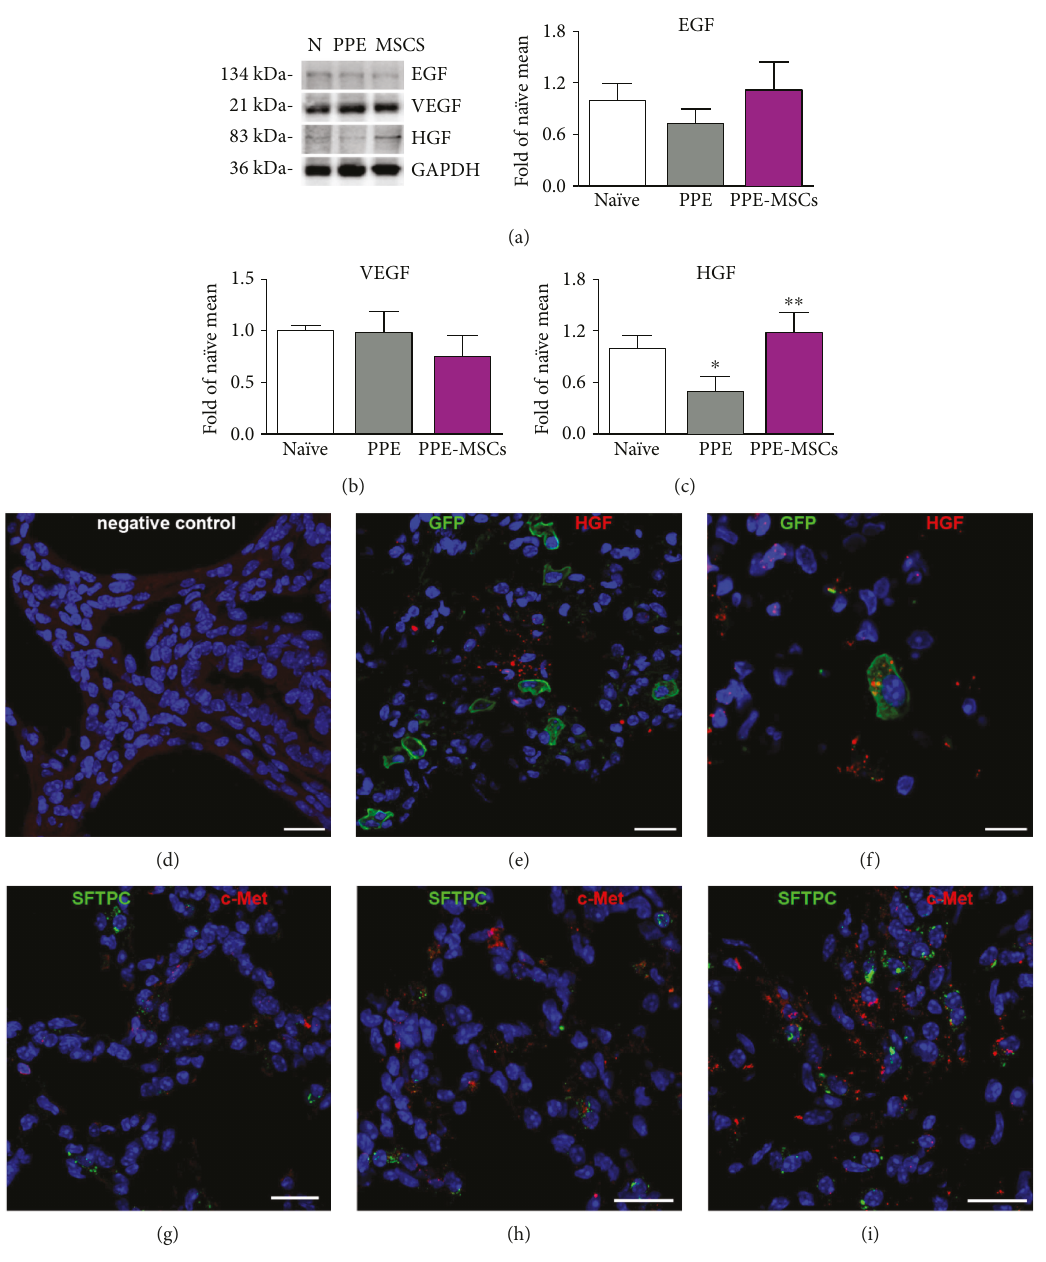
Figure 4: Growth factor pro fi le and MSCs. (a – c) Protein expression of epidermal growth factor (EGF) (a), vascular endothelial growth factor (VEGF) (b), and hepatocyte growth factor (HGF) (c) in the lung by Western blotting. (d) Negative control for HGF staining. (e) Representative images displaying HGF (red) in the proximity of GFP-positive MSCs (green). (f) Intracellular content of HGF (red) in a GFP-positive MSC (green). (g – i) c-Met expression (red) in the lung parenchyma from the naïve (g), PPE (h), and PPE-MSC (i) groups; alveolar type II epithelial cells are shown by SFTPC (green). Nuclei are counterstained with DAPI (blue). Data are expressed as the mean ± SD ( n = 6 in each experimental group). Scale bars: 10 μ m (f) and 20 μ m (g – i). ∗ P < 0 05 versus naïve; ∗∗ P < 0 05 versus